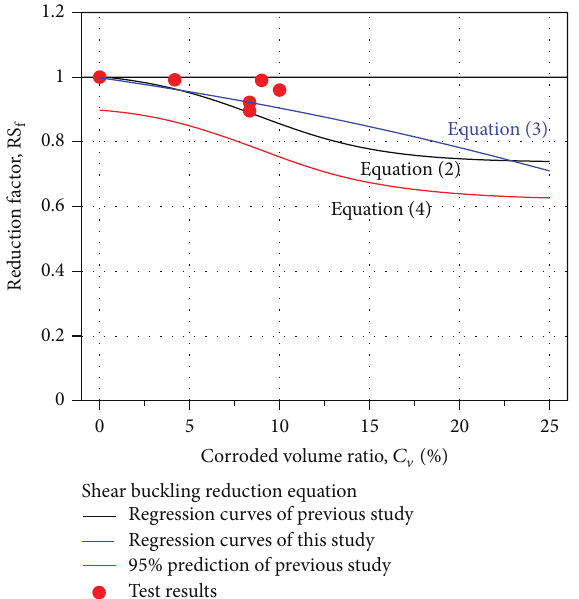
Figure 10: Comparison of test results with suggested shear buckling